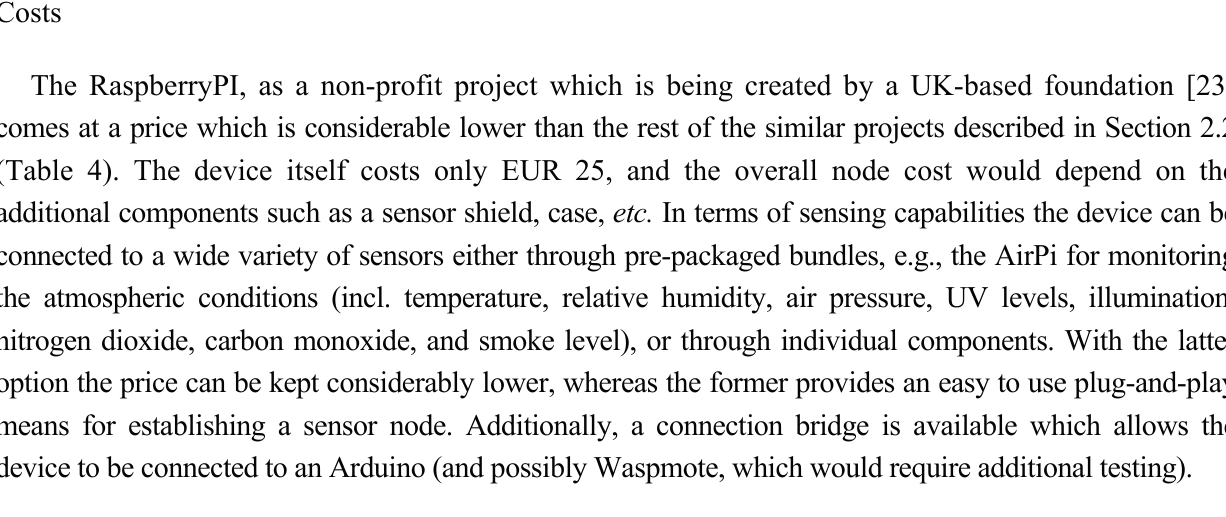
Table 4. Costs and characteristics of RaspberryPI